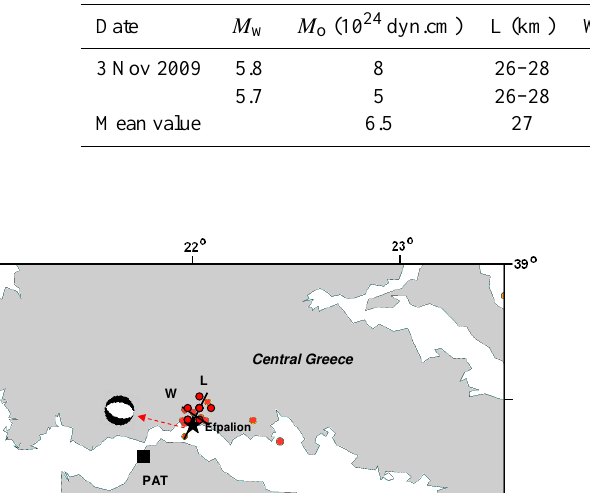
Table 3. The date, the magnitude M w and the seismic moment of event no. 18 along with the range of values in the dimensions of the aftershock area L and W, the corresponding calculated values for 1σ B , the critical exponent α and the associated correlation coefficient R . Mean values are given in the last